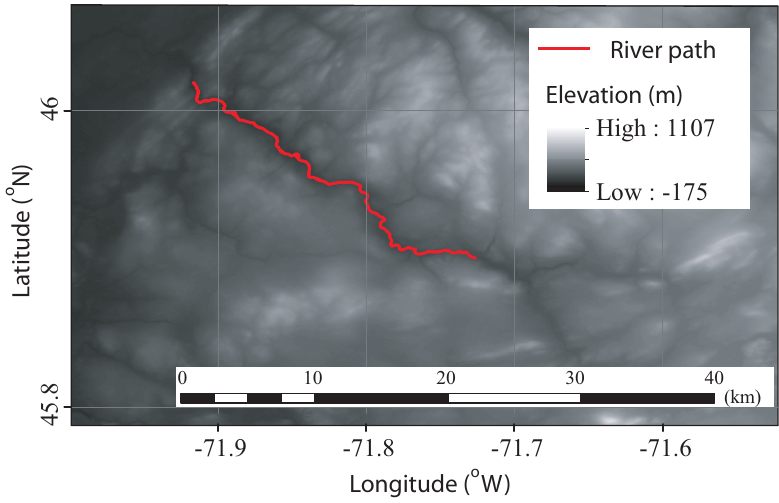
Figure 3. Mapping of the river section (Figure 1b) to the USGS topographic DEM.